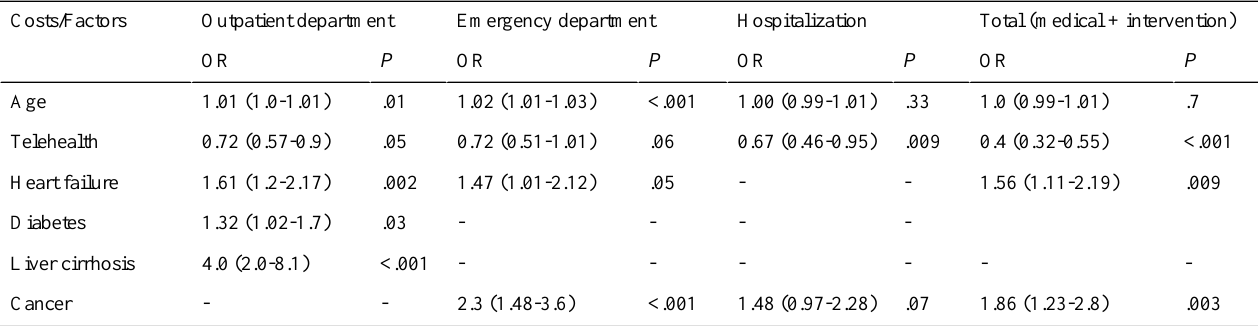
Table 6. Generalized linear models for